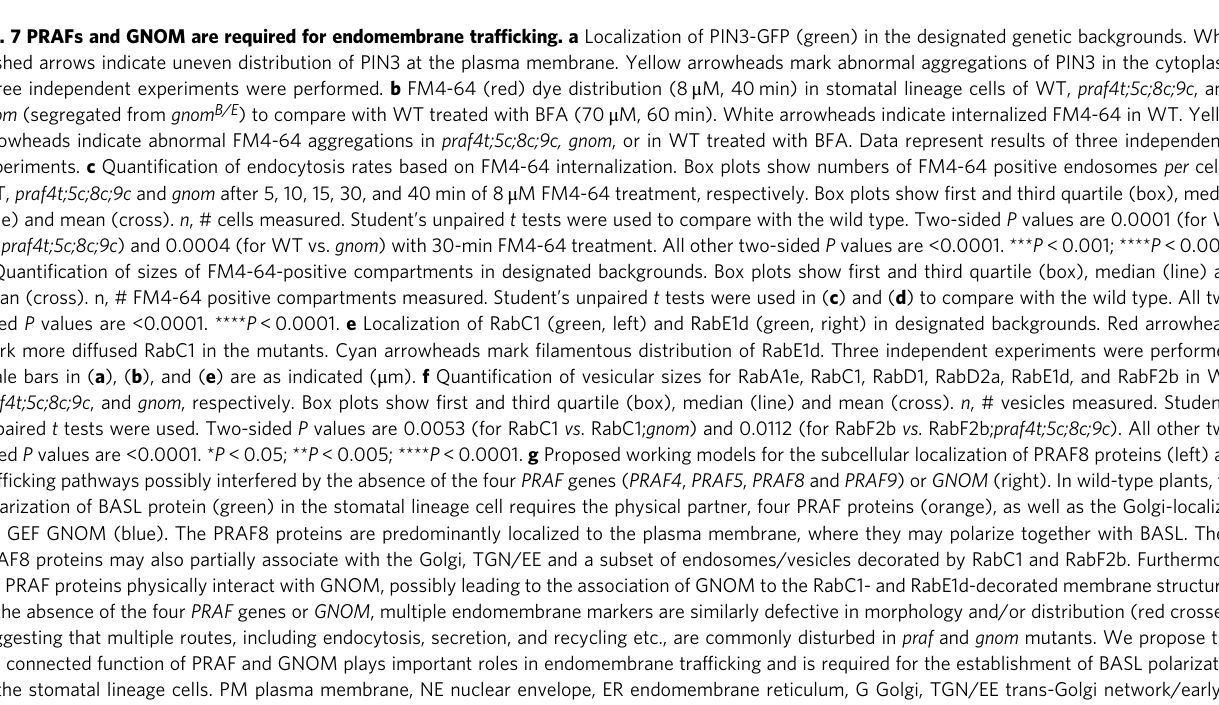
Fig. 7 PRAFs and GNOM are required for endomembrane traf fi cking. a Localization of PIN3-GFP (green) in the designated genetic backgrounds. White dashed arrows indicate uneven distribution of PIN3 at the plasma membrane. Yellow arrowheads mark abnormal aggregations of PIN3 in the cytoplasm. Three independent experiments were performed. b FM4-64 (red) dye distribution (8 μ M, 40 min) in stomatal lineage cells of WT, praf4t;5c;8c;9c , and gnom (segregated from gnom B/E ) to compare with WT treated with BFA (70 μ M, 60 min). White arrowheads indicate internalized FM4-64 in WT. Yellow arrowheads indicate abnormal FM4-64 aggregations in praf4t;5c;8c;9c, gnom , or in WT treated with BFA. Data represent results of three independent experiments. c Quanti fi cation of endocytosis rates based on FM4-64 internalization. Box plots show numbers of FM4-64 positive endosomes per cell in WT, praf4t;5c;8c;9c and gnom after 5, 10, 15, 30, and 40 min of 8 μ M FM4-64 treatment, respectively. Box plots show fi rst and third quartile (box),